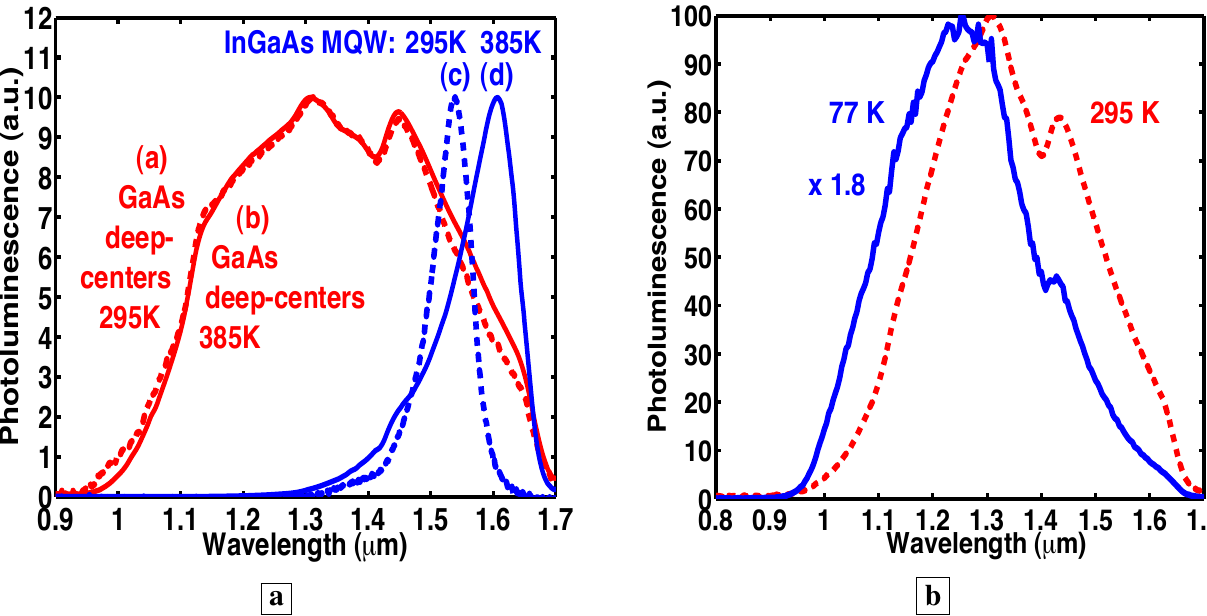
Figure 7 . a, The PL [7] from GaAs deep-centers and high-quality InGaAs MQWs at 295 K (dashed lines) and 385 K (solid lines). b, The PL of GaAs deep-centers at 295 K (dashed line) and 77 K (solid line). All PL have been normalized to the peak